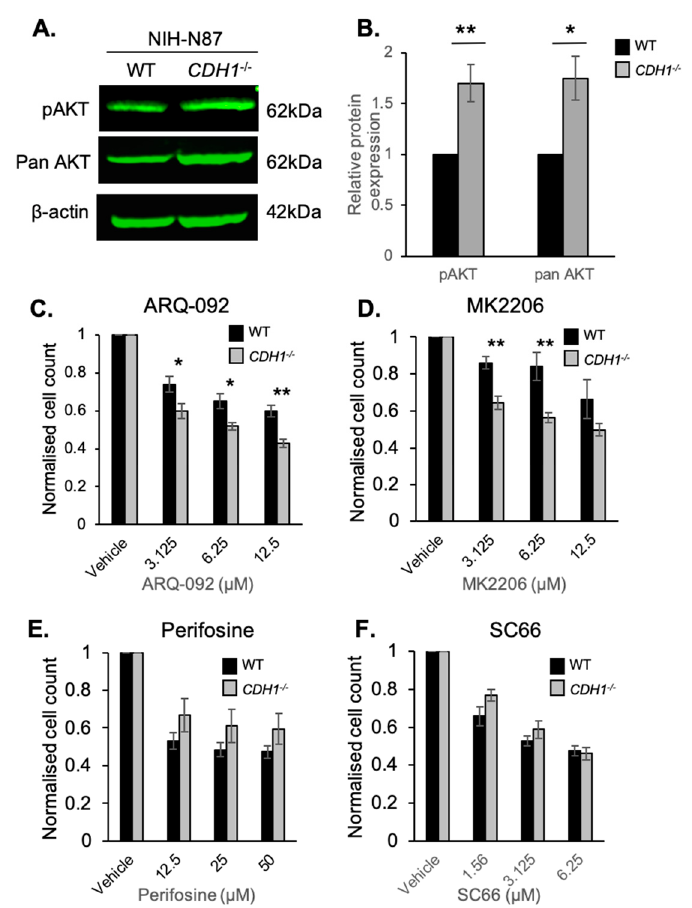
Figure 3. Gastric cancer cells lacking E-cadherin have enhanced sensitivity to the allosteric AKT inhibitors ARQ092 and MK2206. ( A ) Western blots of pAKT-Ser473, pan-AKT, and β -actin in NCI-N87-WT and CDH1 − / − cells. ( B ) Relative expression of pAKT and pan-AKT in NCI-N87-WT and CDH1 − / − cells. ( C – F ) Normalised NCI-N87-WT and CDH1 − / − cell counts 48 h after treatment with serial dilutions of ARQ-092 ( C ), MK2206 ( D ), perifosine ( E ), and SC66 ( F ). Wild-type, black bars; CDH1 − / − , grey bars. Six fields per well at 4 × magnification were captured using the Cytation 5 imager (Biotek). Nuclei were counted using Gen5 (Biotek, Winooski, Vermont) and normalised to the vehicle control for each cell line. (For all graphs, error bars = SEM; ns = p > 0.05, * = p < 0.05, ** = p < 0.01, n ≥ 3 independent biological replicates; unpaired two-sided t -test.)